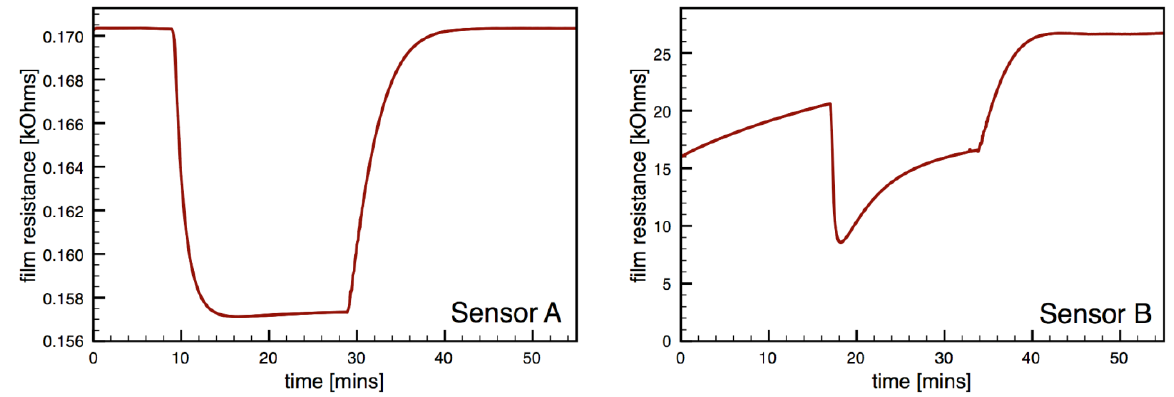
Figure 6. Sensor performance for distributed gold additives; sensor architectures A and